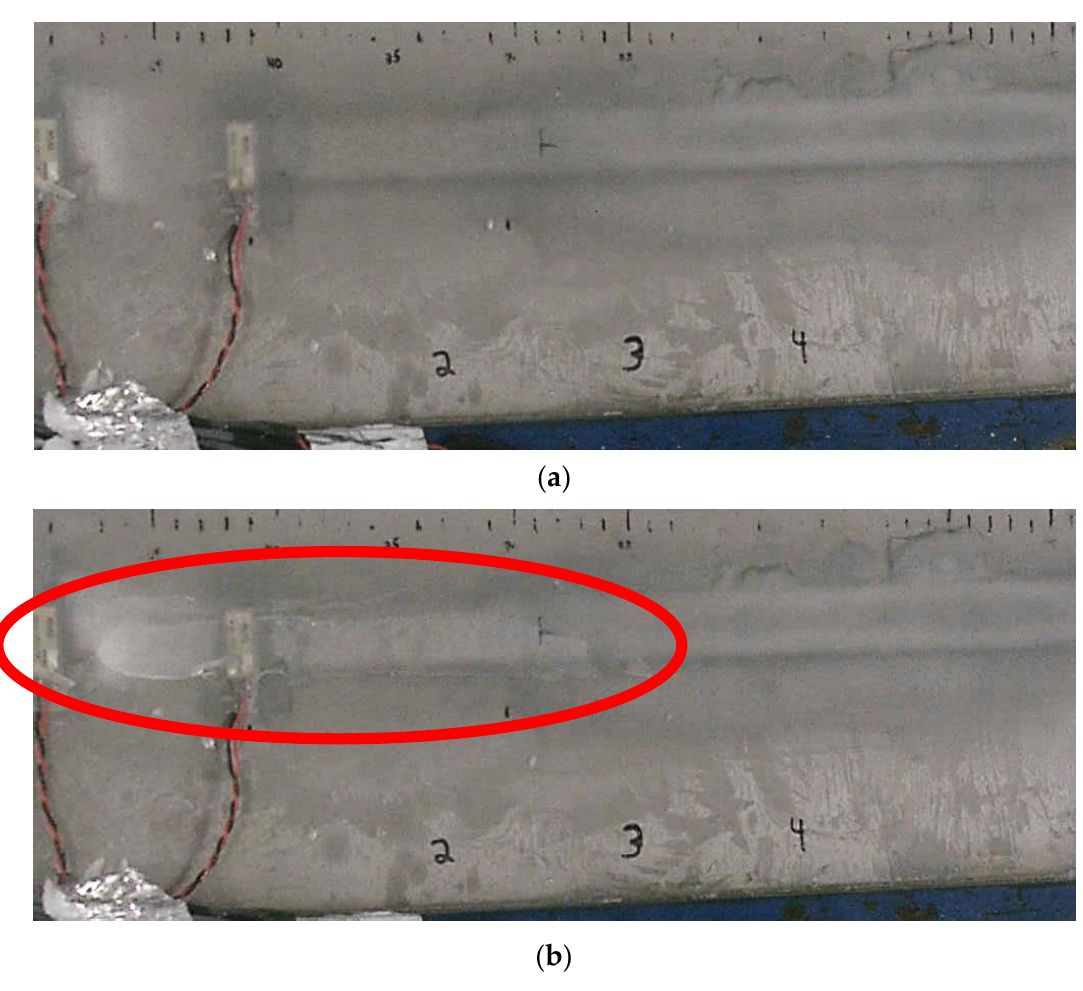
Figure 10. Pictures captured after 5.568 ( a ) and 5.672 s ( b ) with the camera during a frequency sweep